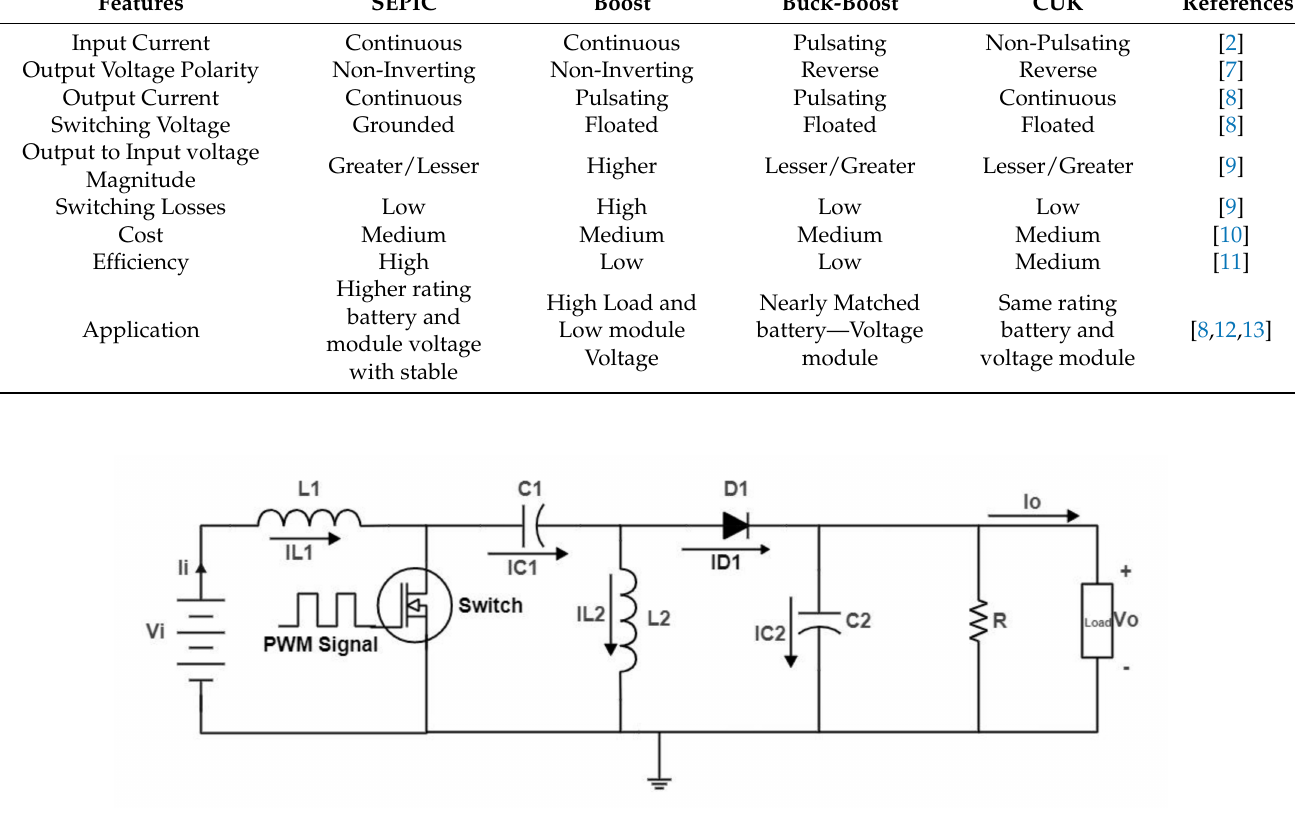
Figure 4. Circuit diagram of SEPIC